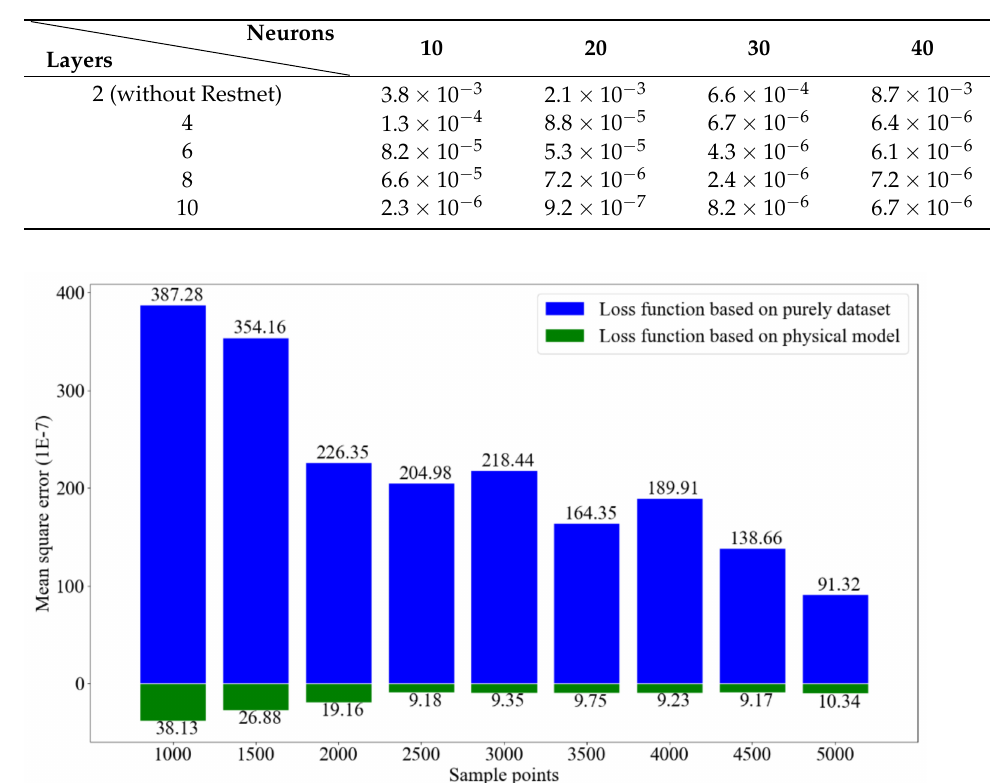
Figure 4. Burger’s equation informed neural network. Table 1. The mean square error between predict value and exact value in validation set with different layers and neurons.